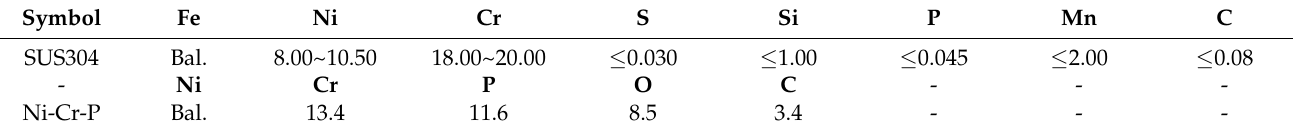
Table 1. Chemical composition of SUS304 and electrodeposited Ni-Cr-P alloy coating (mass%).